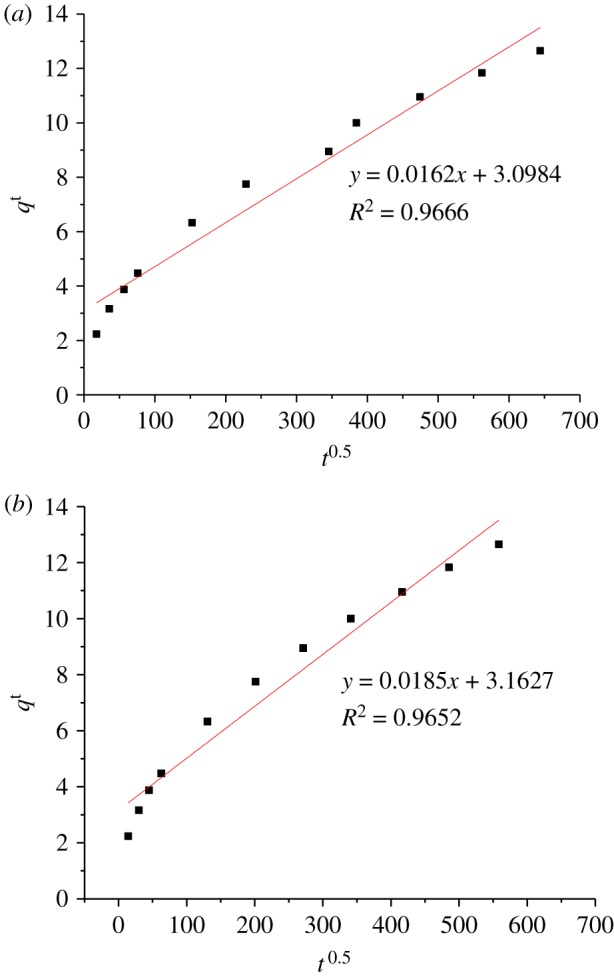
Linearized intraparticle diffusion kinetic model of 2,4-DNP sorption onto (a) βCD-TDI and (b) βCD-HDI.